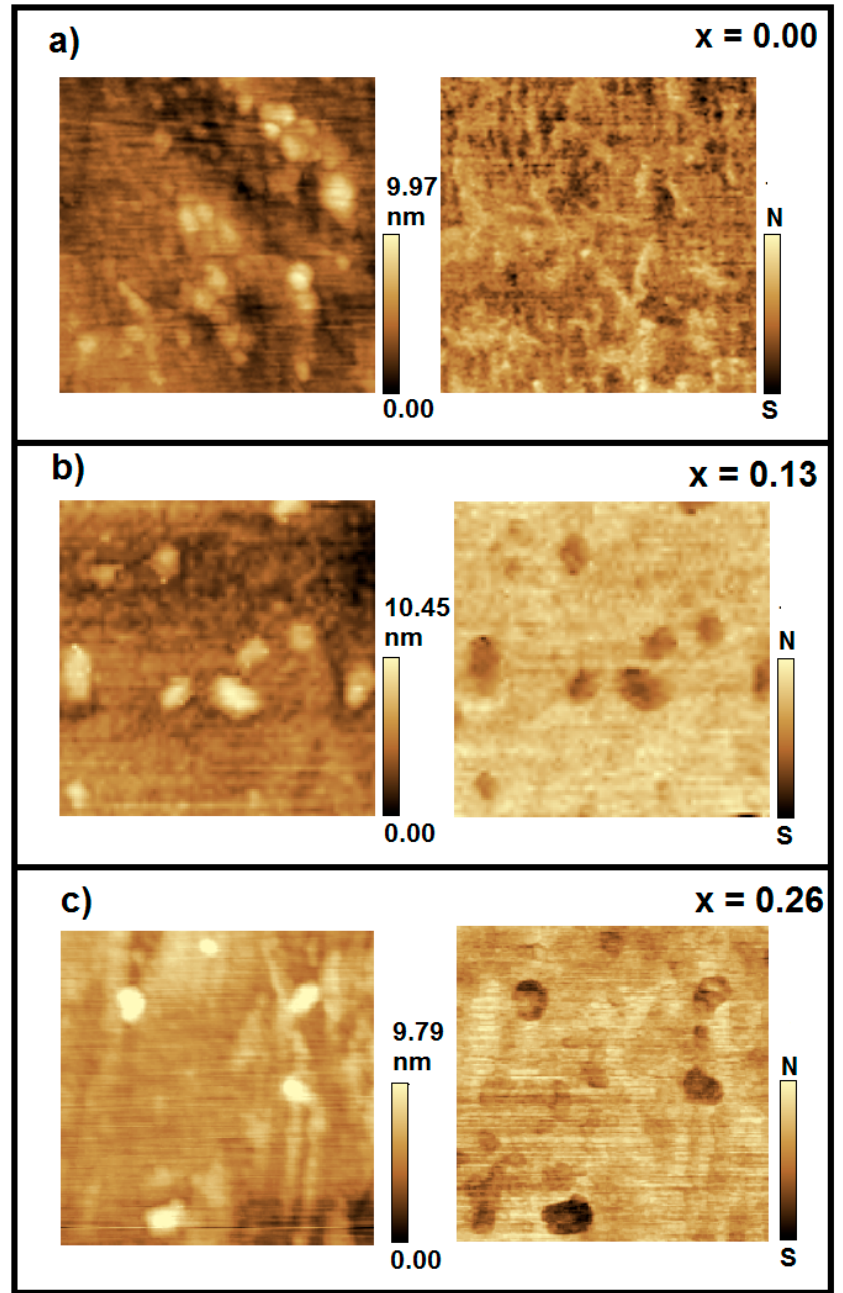
Figure 2. AFM/MFM images of 700 × 700 nm of Bi 2 − x Fe x S 3 nanocrystals grown in the SNAB glass matrix, heat treated at 500 °C for 24 h, at concentrations: ( a ) x = 0.00; ( b ) x = 0.13; and ( c ) x = 0.26. Sample topographic ( left panel) and magnetic phase ( right panel) identifies the orientation of the total magnetic moment of the DMS NCs.